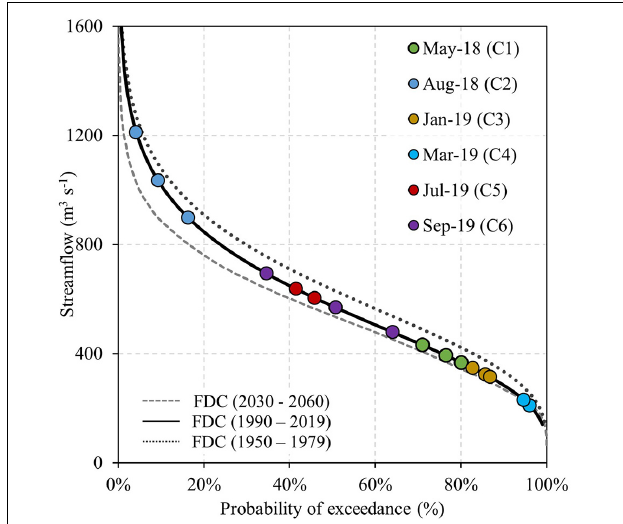
FIGURE 2 | Flow Duration Curve (FDC) of the monthly streamflow of the Puelo River for different periods. The projected streamflows for the period 2030–2060 were obtained from Aguayo et al. (2019). The colors of the circles correspond to the six field campaigns performed in the Puelo River Basin and the Reloncaví